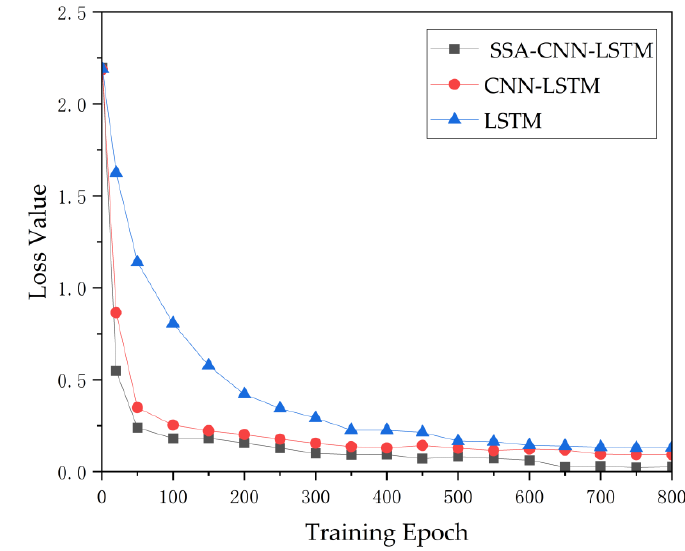
Figure 7. Accuracy of the training dataset.